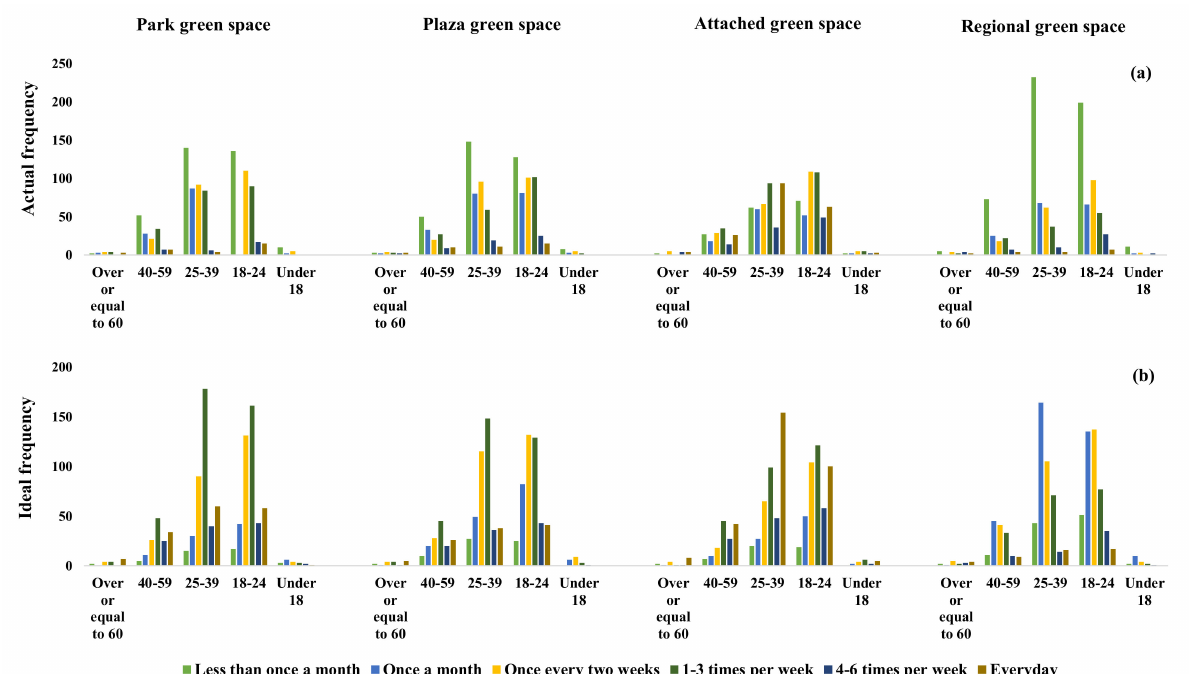
Figure 6. ( a ) The actual and ( b ) ideal frequencies of urban residents’ visits to different green space types concerning age. The x-axis represents the age of the respondent and the y-axis represents the number of people who chose to go to that frequency for that green space